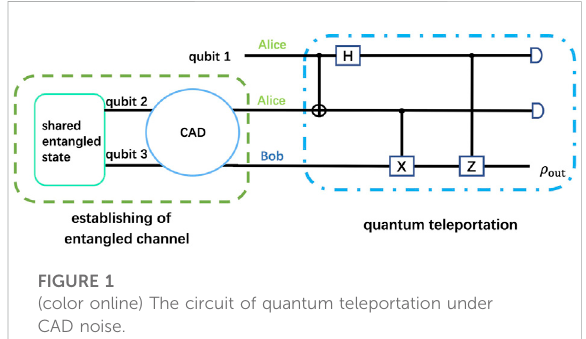
FIGURE 1 (color online) The circuit of quantum teleportation under CAD